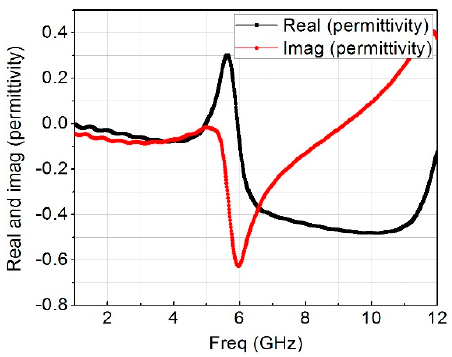
Figure 10. Metamaterial permeability, real & imaginary parts.